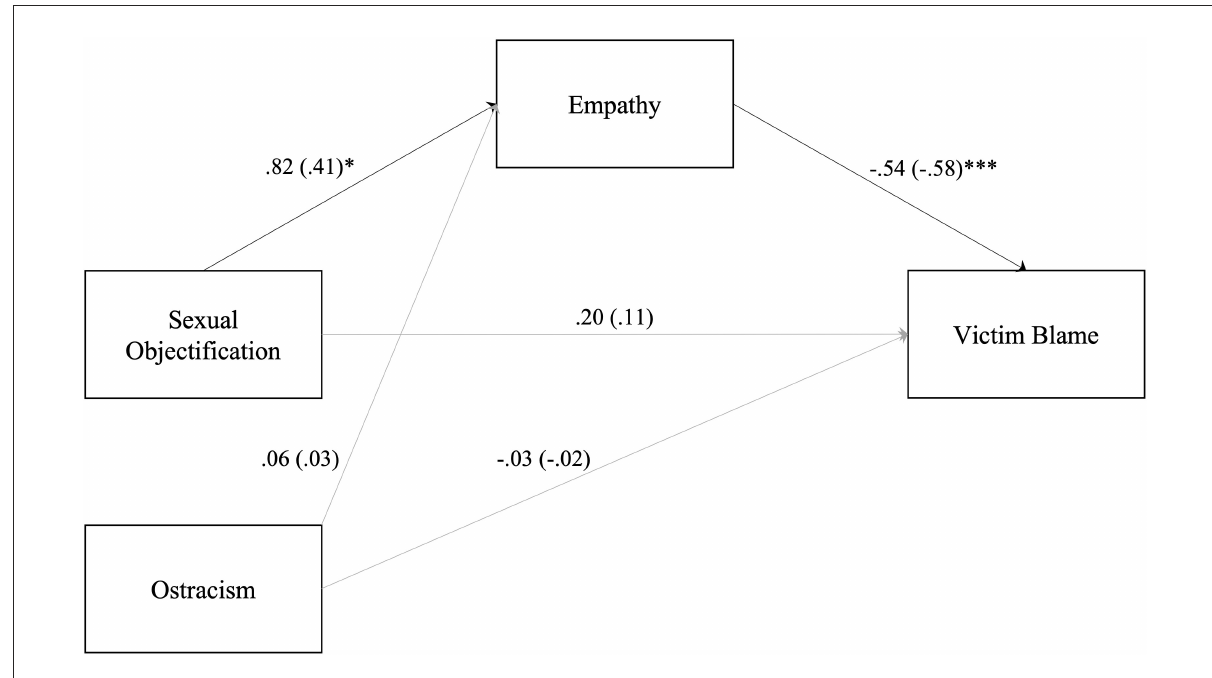
FIGURE1 Mediation model presenting the mediating role of empathy in the effects of sexual objectification (body condition) vs. neutral (face condition) and ostracism (away condition) vs. neutral on victim blame. * p < 0.05, *** p <